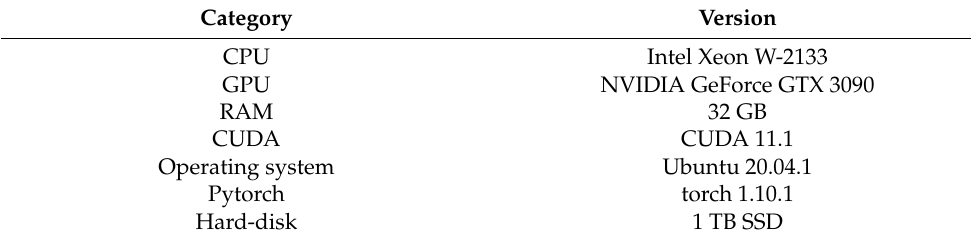
Table 4. Experimental